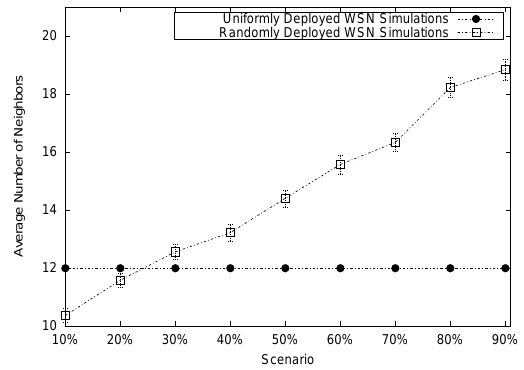
Figure 8. Average number of neighbours per location-unknown node and its 95% confidence intervals.